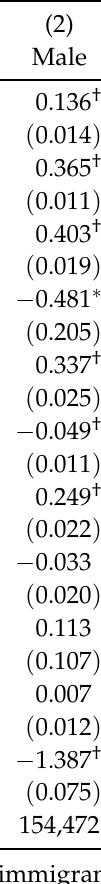
Table 4: Models for STEM Orientation Including Interaction Effects Between Gender, Individual Achievement, and National and School Math-Science